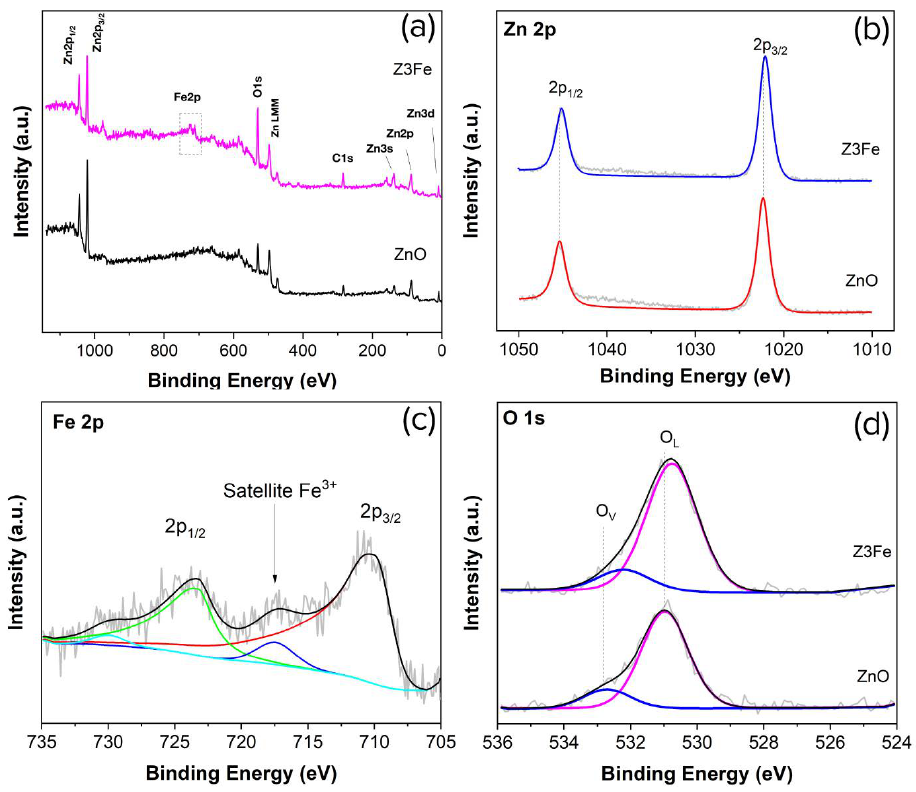
Figure 4. XPS spectra of ZnO and Z3Fe thin films: overview ( a ), Zn 2p ( b ), Fe 2p ( c ), and O 1s ( d ); on the spectra ( c , d ), coloured lines indicate the different